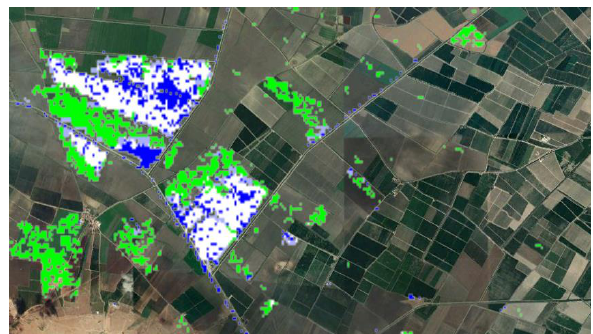
Figure 11. SPOT vs SAR Riverside Detailed